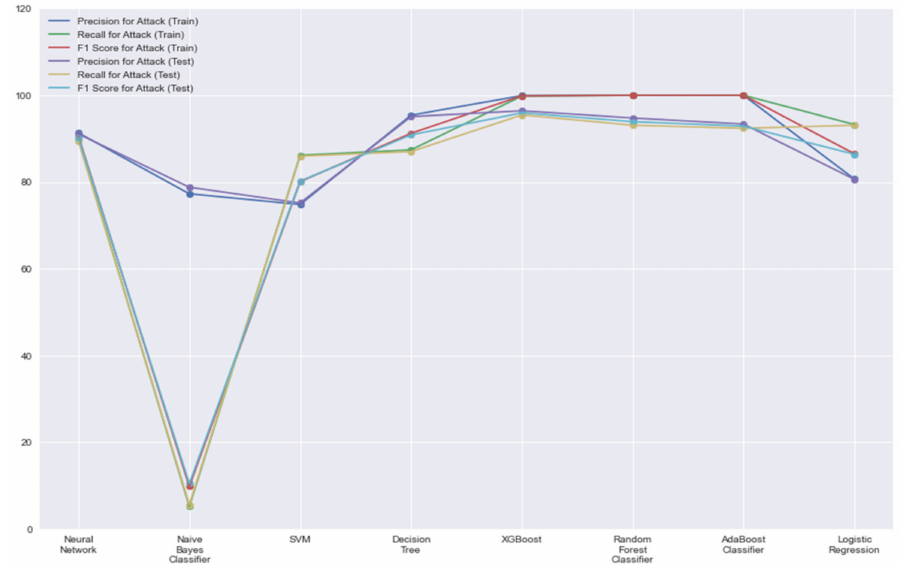
Figure 4. Classification report for ‘Attack’